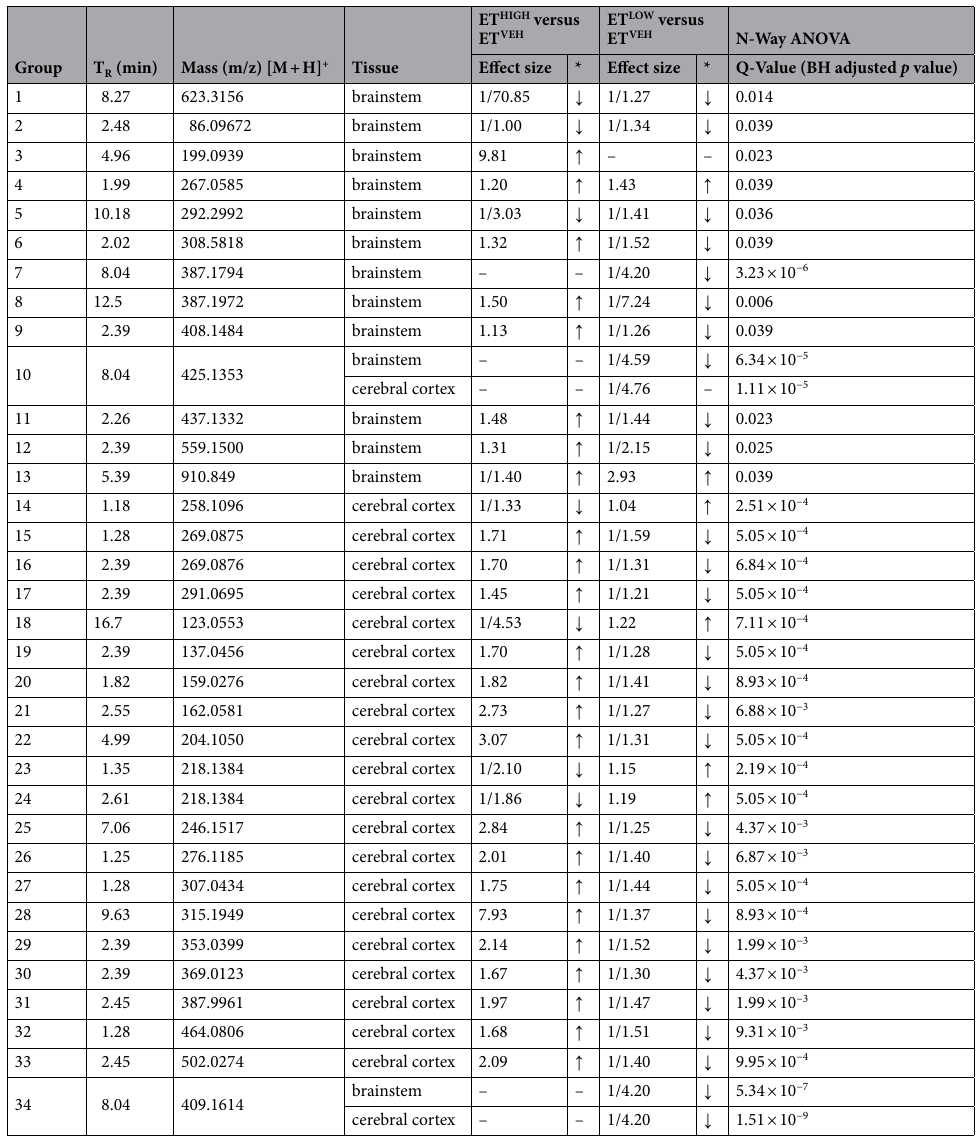
Table 2. Summary of significant unknown metabolites altered in the brain (cerebral cortex and brainstem) in ergotamine treated mice compared to control. * ↑ = Up-regulated, ↓ =